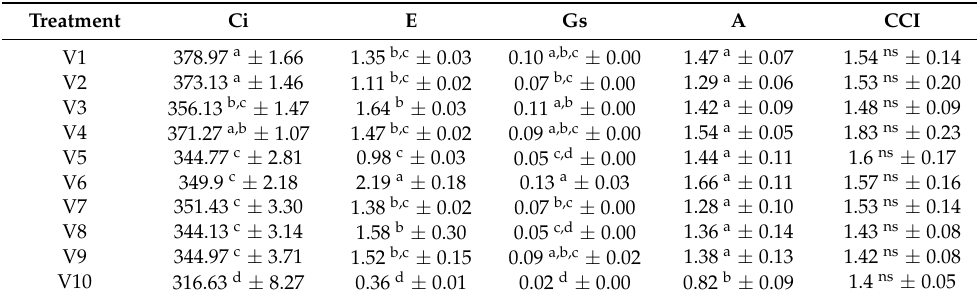
Table 4. Gas exchange parameters and total chlorophyll content of wheat grass cultivated on pond sediment.